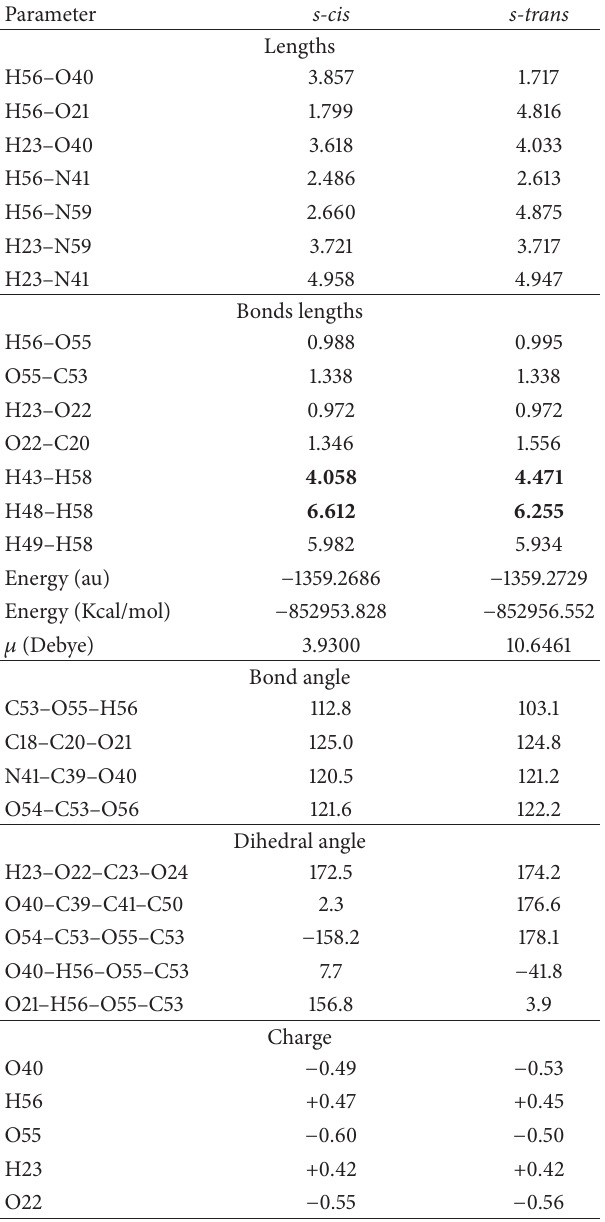
Table 1: Selected bond lengths (˚A) and angles (deg) for the cis and trans isomer of